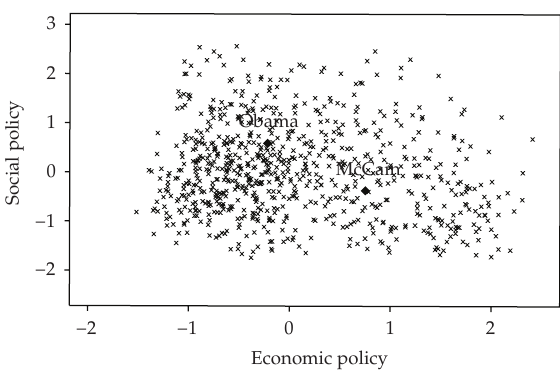
Figure 2: Distribution of voter ideal points and candidate